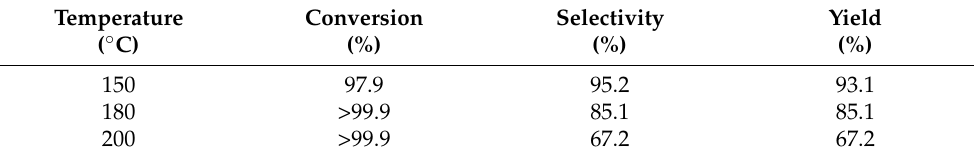
Table 4. The PO conversion, PC selectivity, and PC yield using the APTMS-modified Zr–Mg mixed oxide aerogels with Zr/Mg molar ratio of 7/3 under four APTMS modifications at different reaction temperatures.